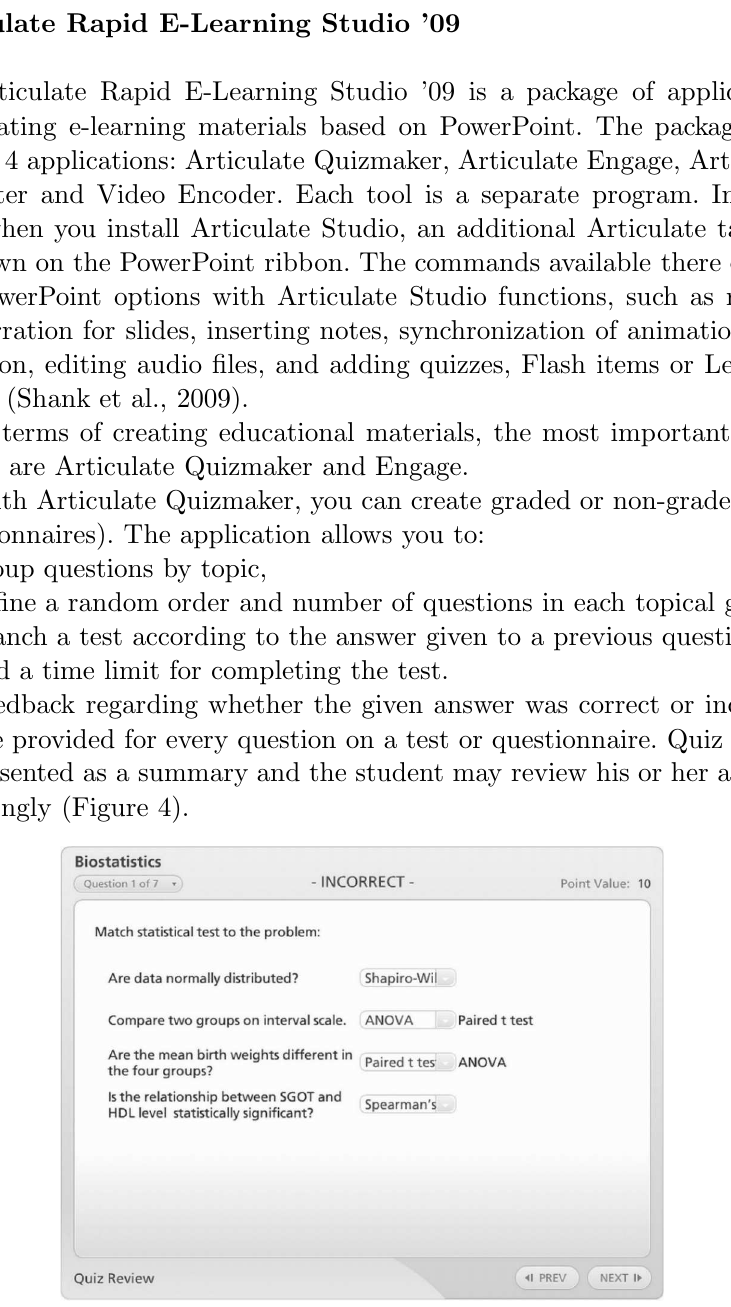
Figure 4. Quiz review with feedback comments – biostatistics material for medical